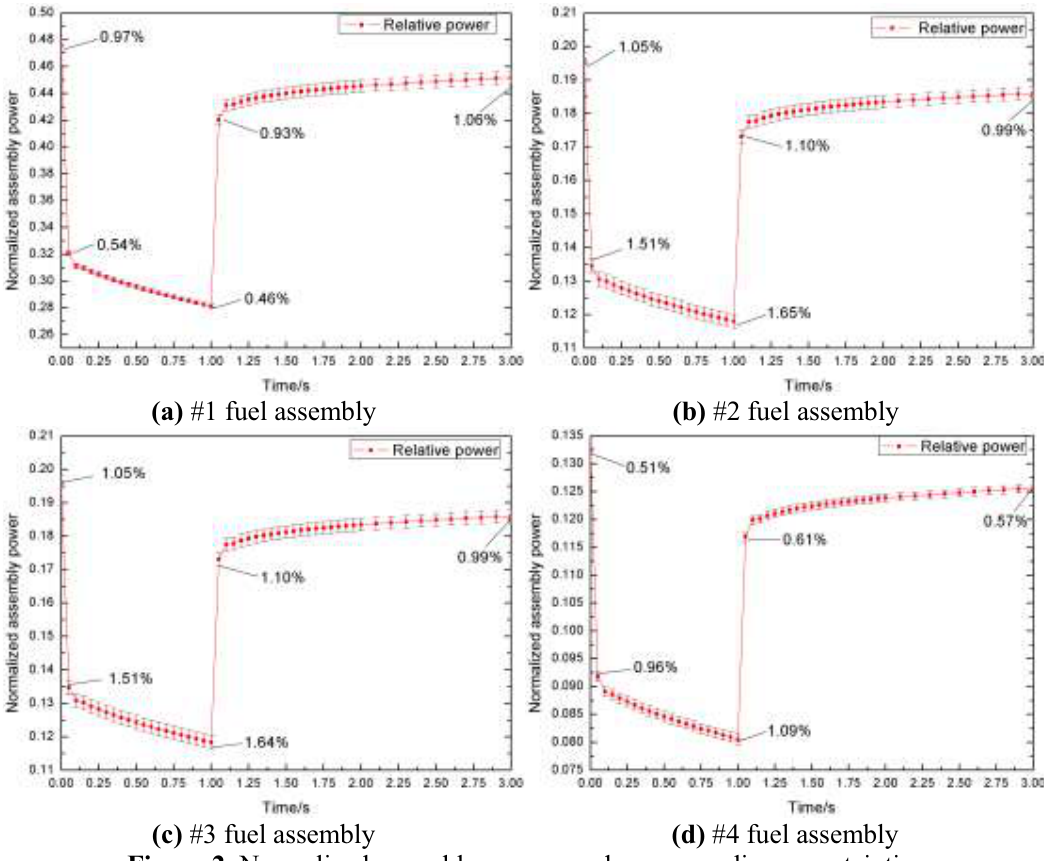
Figure 2. Normalized assembly powers and corresponding